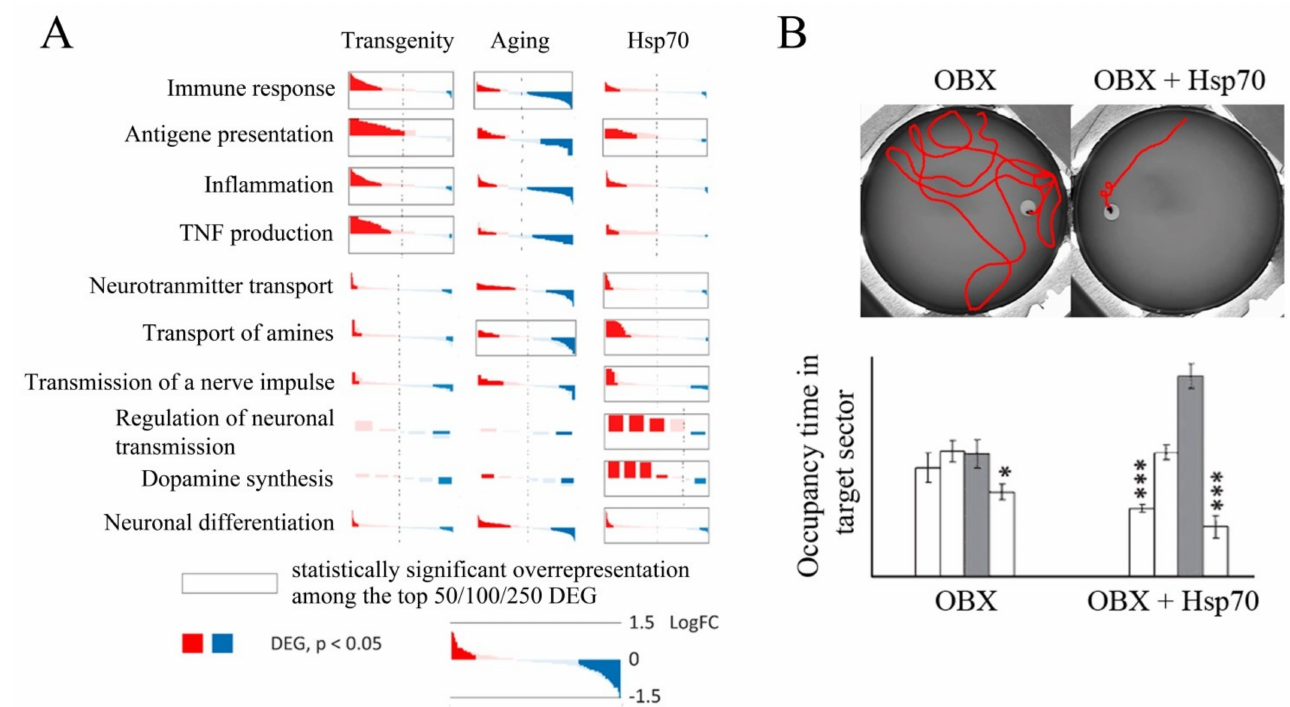
Figure 5. ( A ) Differentially expressed genes (DEGs) in transgenic 5XFAD mice, ageing mice, and transgenic mice after administration of exogenous Hsp70. ( B ) Restoration of spatial memory in bulbectomized (OBX) mice as indicated by performance in the Morris maze when exogenous Hsp70 is administered. *— p < 0.05; ***— p <